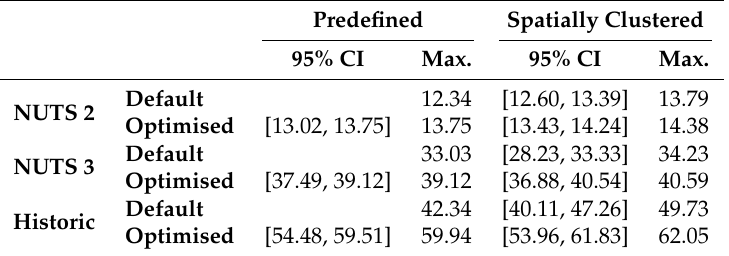
Table 4. A comparison between the median ICM values of the three different identity region configurations and the median ICM value distributions of the same number of randomly generated spatially clustered regions, both optimised and non-optimised. Fifty samples were taken for distributions that involve the optimisation algorithm and 250 samples were taken for each of the non-optimised distributions that consist of randomly spatially clustered regions. Predefined Spatially Clustered 95% CI Max. 95% CI